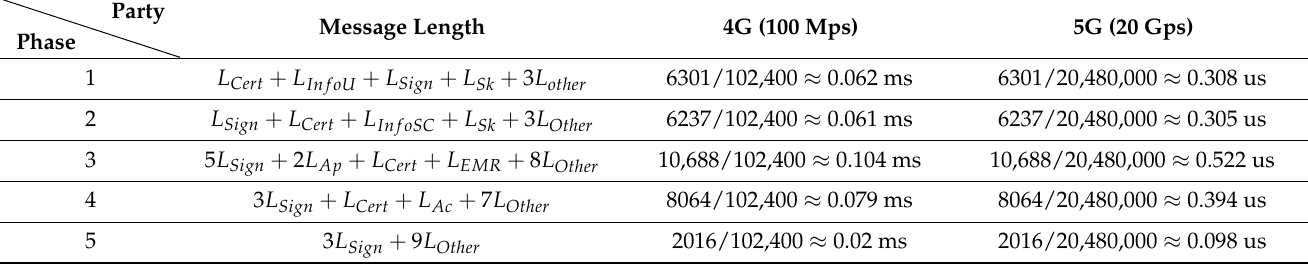
Table 8. The communication performance of the proposed scheme in different